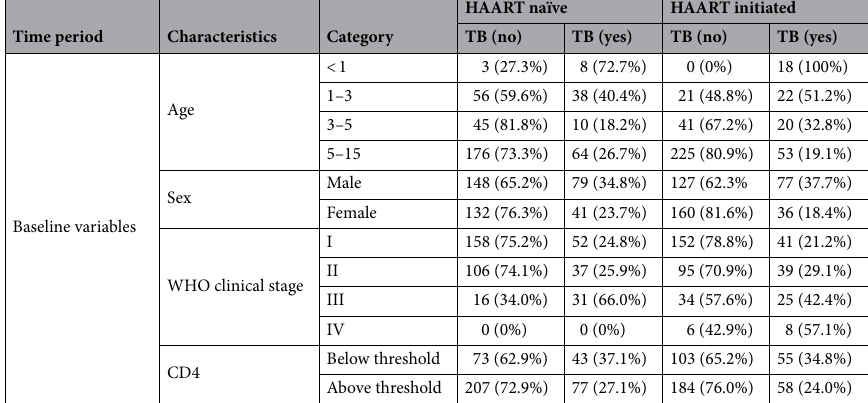
Table 1. Characterstics of HAART initiated and HAART naïve children. WHO world health organization, TB Tuberculosis.